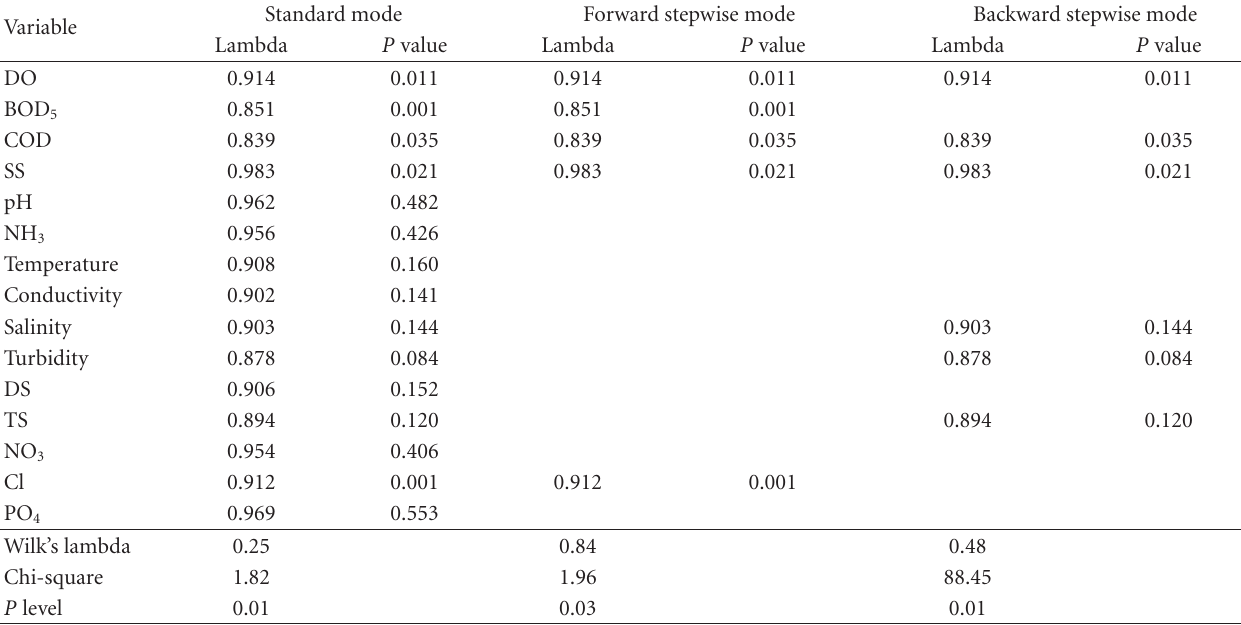
Table 3: Wet season classification function for discriminant analysis (DA) of parameters in mg/L except for temperature, conductivity, and pH.